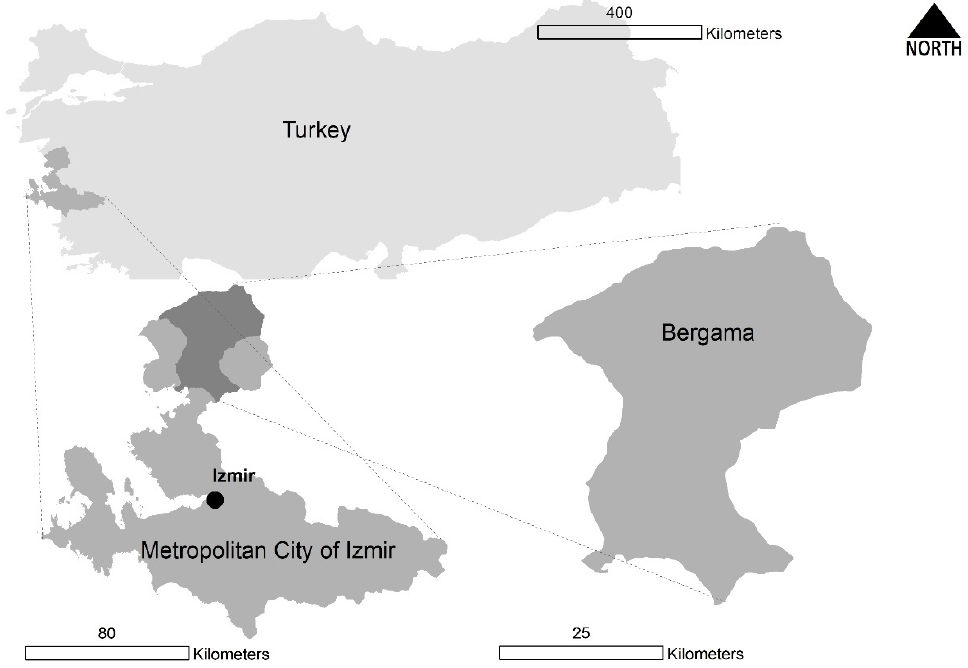
Figure 1. The location of Bergama district in the Izmir’s Province. Source: author’s elaboration.